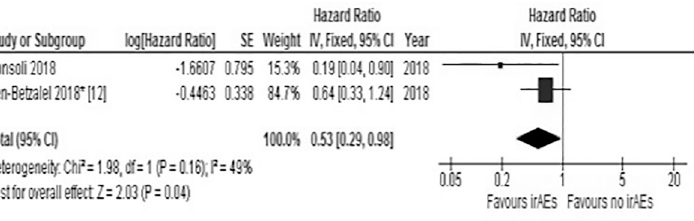
Fig 5. Meta-analysis of effect of immune related adverse effect during target therapy on progression-free survival (PFS). � Calculated Hazard Ratio and Confidence interval (CI) from the survival curves provided in the original report of Ben-Betzalel et al [12]. irAEs, immune related adverse